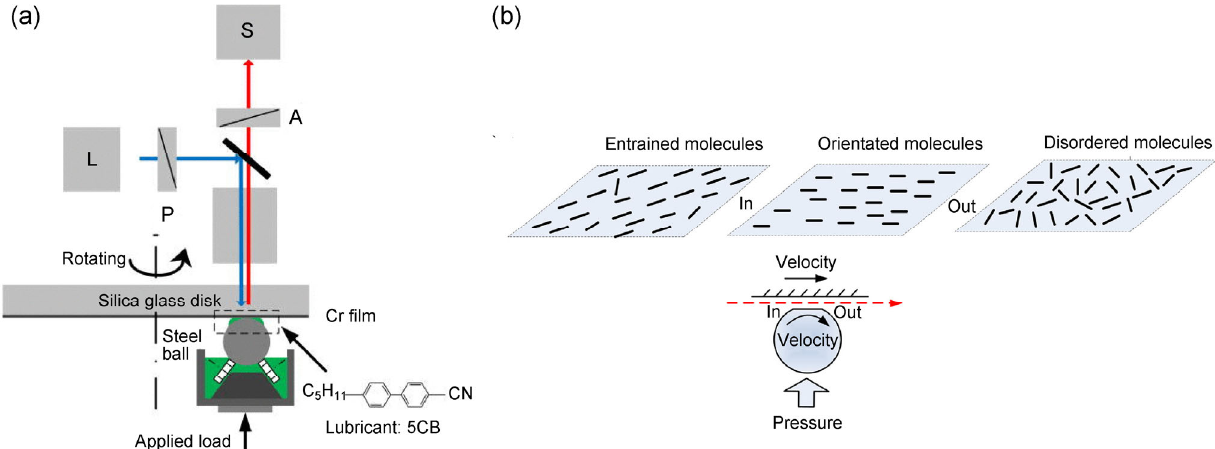
Fig. 7 (a) Schematic diagram of the in-situ experimental apparatus in Luo’s group [74]. (b) The orientated liquid crystal molecules between two rubbing surfaces reported by Zhang et al. [74]. Copyright 2014, AIP Publishing